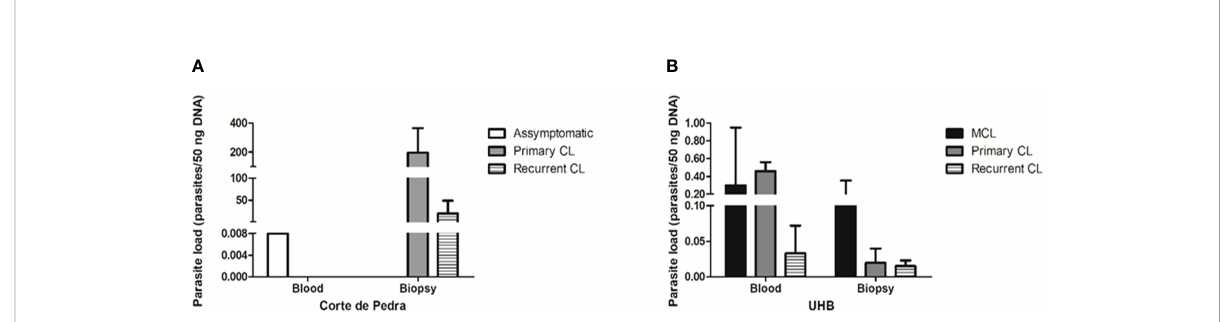
FIGURE 2 Parasite load of different samples of the studied groups, as determined by qPCR. (A) Parasite load (parasites/50 ng DNA) by sample type and clinical manifestation from patients of Corte de Pedra. (B) Parasite load (parasites/50 ng DNA) by sample type and clinical manifestation of patients attended at Bras ı ́ lia University Hospital (UHB). Legend: CL, Cutaneous leishmaniasis; MCL, Mucocutaneous leishmaniasis.